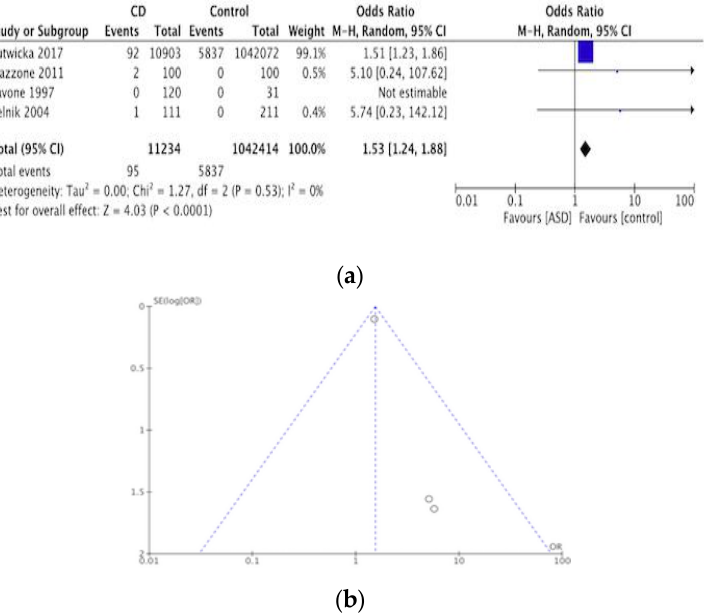
Figure 2. ( a ) Forest plot of pooled prevalence of ASD in CD. ( b ) Funnel plot investigating distribution in ASD studies.